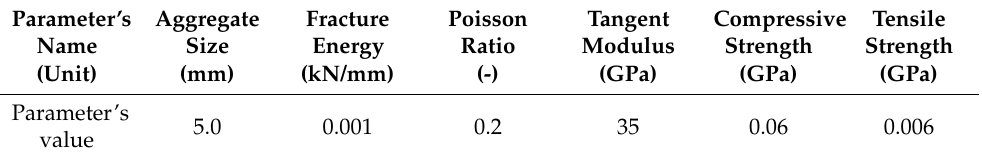
Table 8. Initial seed vector of input parameters’ values of the Winfrith material model used in the